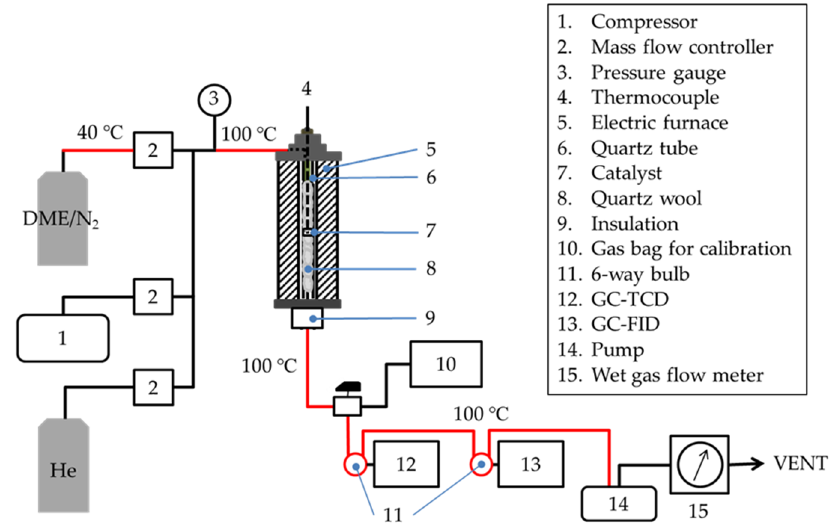
Figure 8. Schematic of the experimental apparatus for DTO reaction.